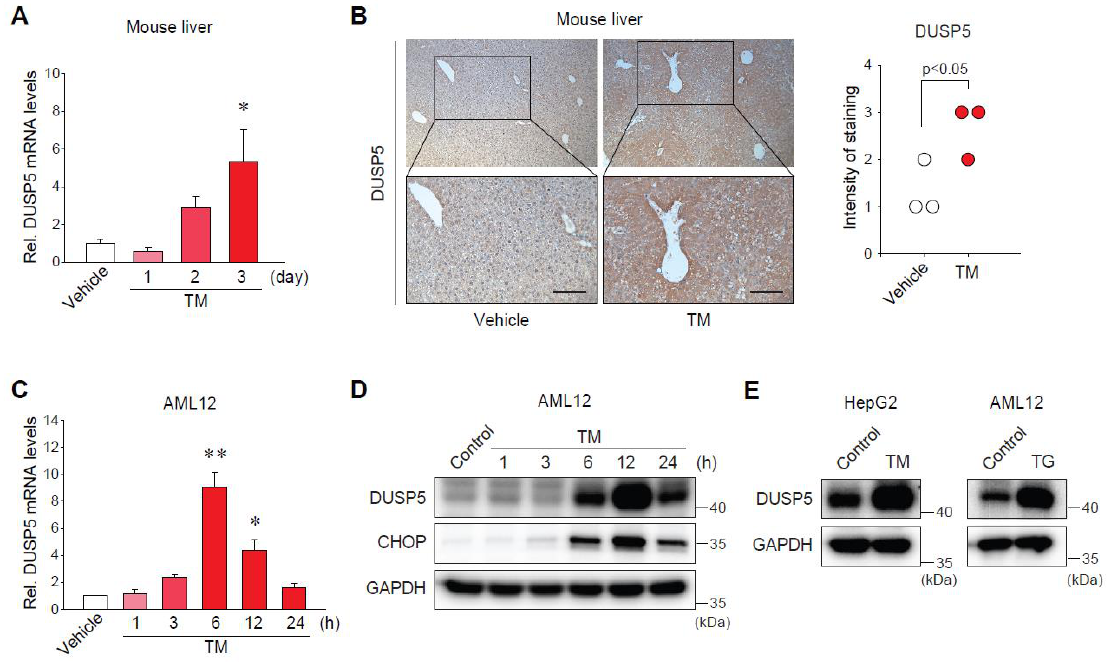
Figure 2. Endoplasmic reticulum (ER) stress increases the expression of DUSP5 in hepatocytes. ( A ) qRT-PCR assay for hepatic DUSP5. Mice were treated with vehicle or tunicamycin (TM, 2 mg/kg,